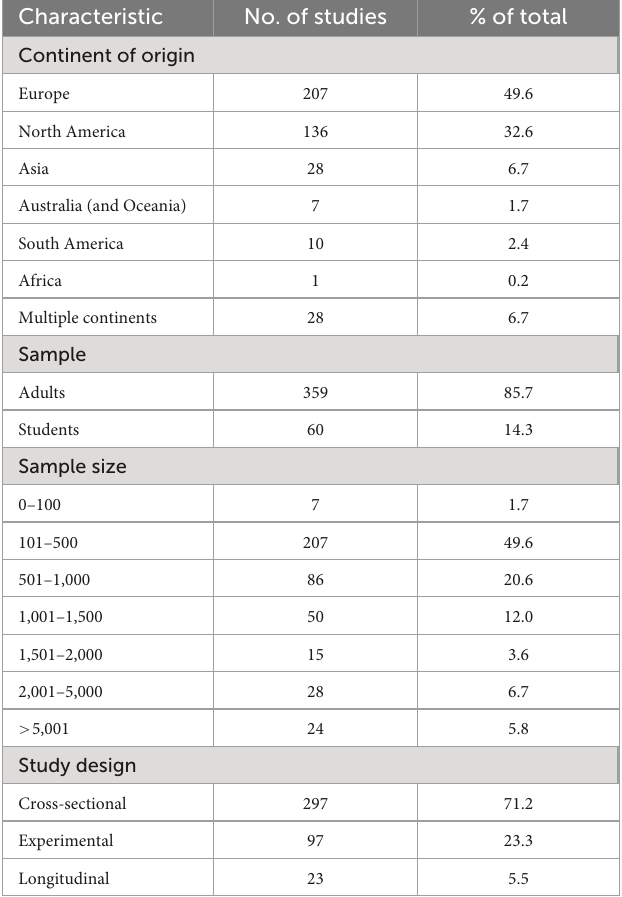
TABLE 1 Characteristics of the studies included in the current